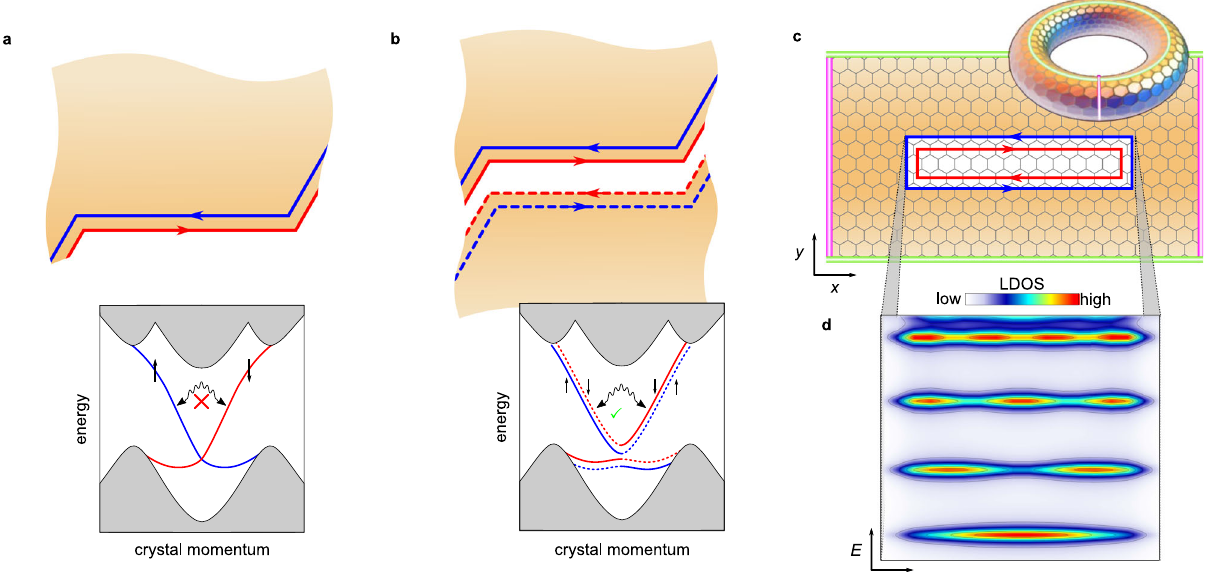
Fig. 1 Free vs. coupled helical edge states. a Edge segment of a generic 2D TI material. A pair of helical edge states is bound to the edge. Back-scattering from defects such as the edge kinks is impeded by topologically protected spin-momentum locking, i.e., left-moving spin-up states (blue) cannot scatter with right-moving spin-down states (red). The corresponding one-dimensional band structure is schematically depicted below, where the arrows represent the electron spin projection and the wavy line indicates (prohibited) single-particle backscattering. b Two opposing edge segments in close proximity. Spatial overlap of both pairs of helical edge states induces hybridization (or tunneling) between both edges, thereby allowing inter-edge scattering from one segment to the other across the boundary. Strikingly, this opens a channel for back scattering from the edge kinks, i.e., the topological protection becomes partially lifted due to inter-edge hybridization. The corresponding band structure and the now allowed single-particle backscattering is depicted below. c Tight-binding model of coupled edge states in the 2D TI bismuthene. The white area indicates a topologically trivial line defect along the x - direction embedded in the topological bulk (light brown). The green and pink boundaries of the fi nite-size bulk are connected via periodic boundary conditions, resulting in the depicted torus. The trivial line defect connects two opposite edges; the resulting wave function overlap between both sides induces hybridization of like-spin edge states across the line defect ( y -direction) as in b . d Energy-dependent LDOS of the tight-binding model along the line defect in c (integrated across its y -width). The line defect induces standing wave excitations bound to its longitudinal extent (along x ) and, as the underlying helical states of bismuthene exhibit an approximate linear dispersion, are linearly quantized in energy E . For details of the calculation see Supplementary Sec.